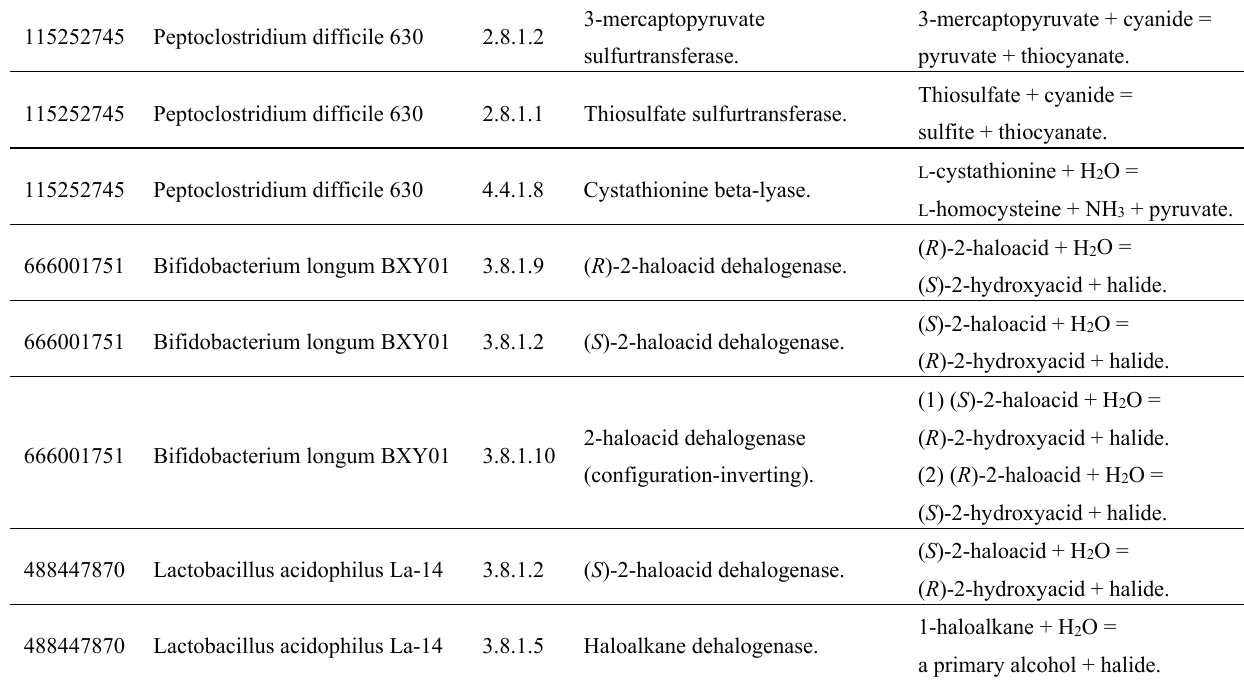
Table 11. Enzymes of interest coded by the “autism” microbiome in Query